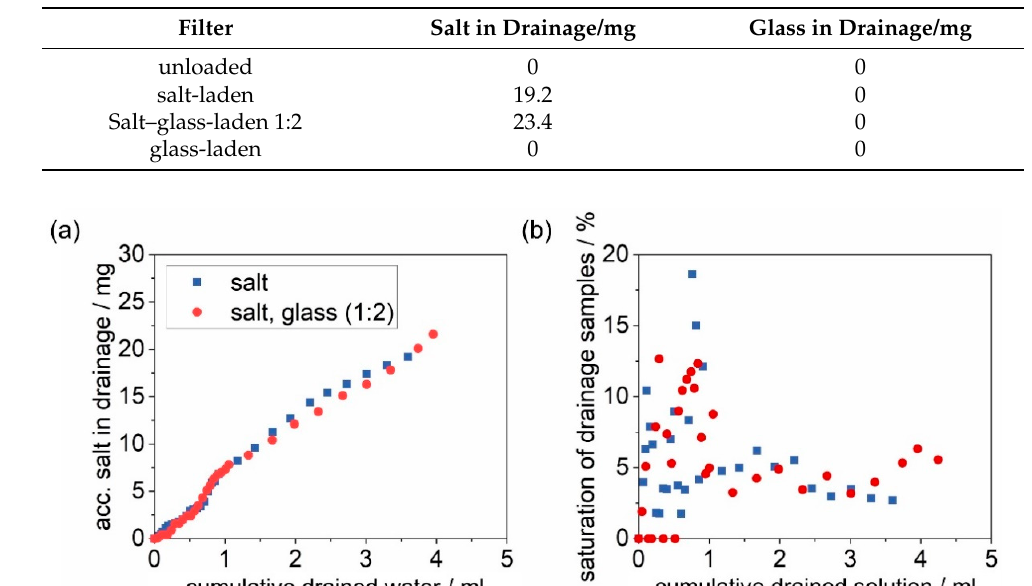
Table 1. Analysis of drainage in total amounts.